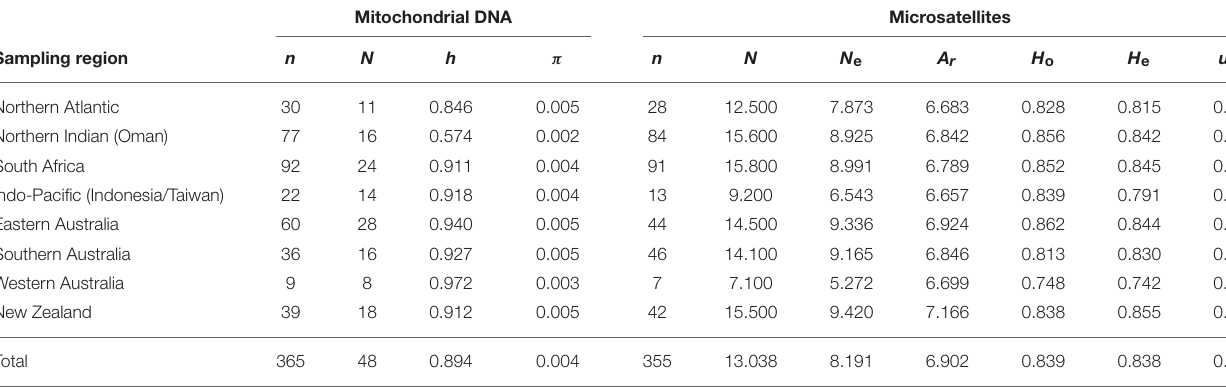
Datawereobtainedfromnnumberofindividuals.Mitochondrialdiversityissummarizedbythenumberofhaplotypes(N),haplotypicdiversity(h)andnucleotidediversity( π ).Microsatellite diversityissummarizedbythenumberofallelesperlocus(N),effectivenumberofalleles(N e ),allelicrichness(A r ),observedheterozygosity(H o ),expectedheterozygosity(H e )andunbiased